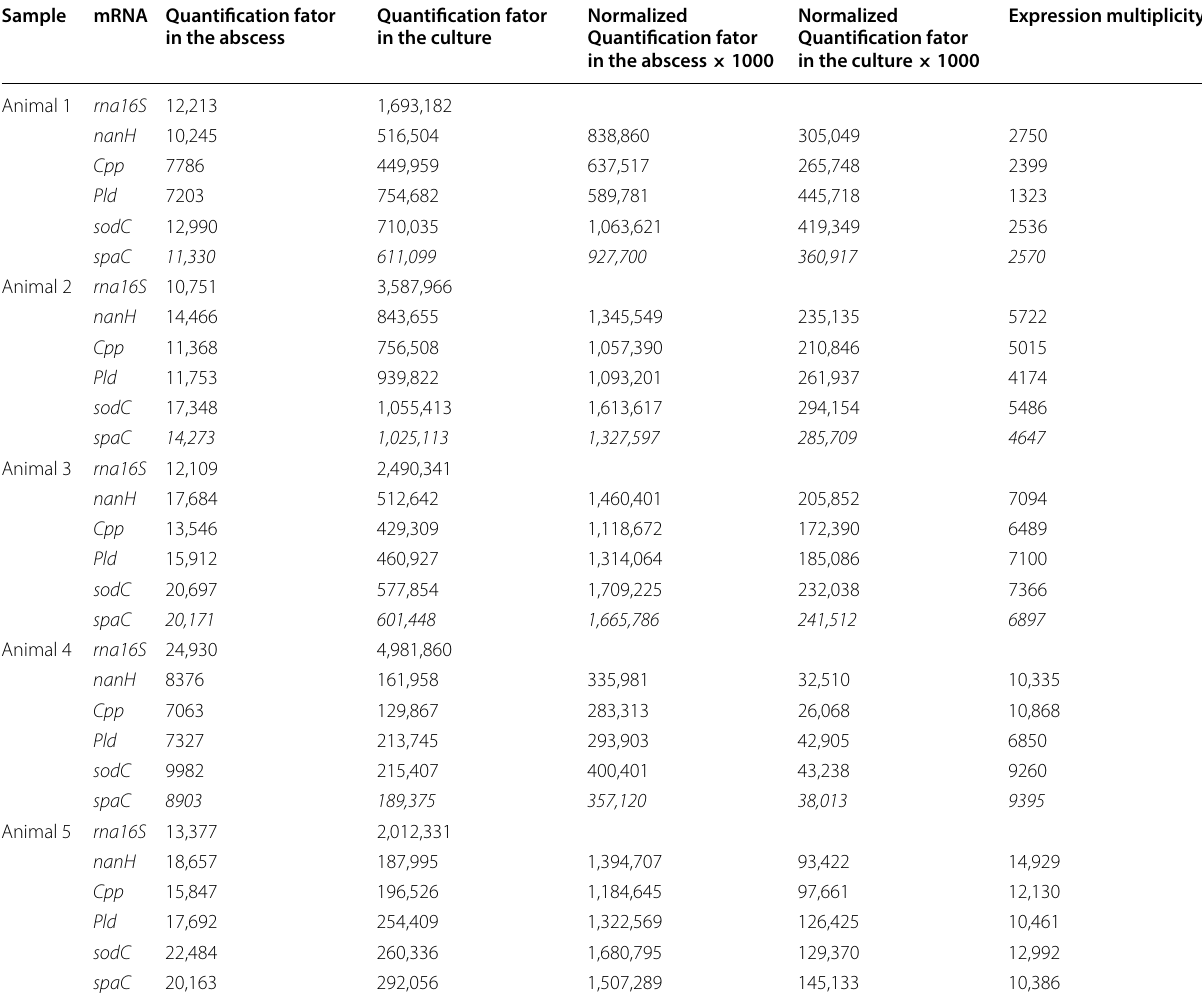
Table 1 Relative quantification and exression multiplicity of nanH , cpp , pld , sodC and spaC genes from Corynebacterium